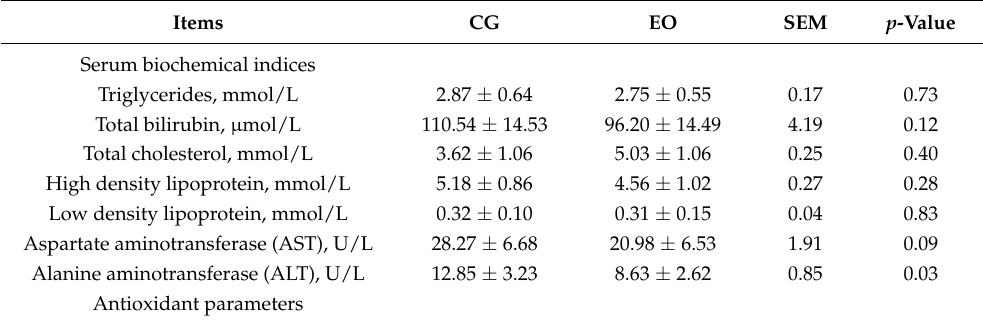
Table 3. Effects of EO supplementation on serum biochemical indices and antioxidant